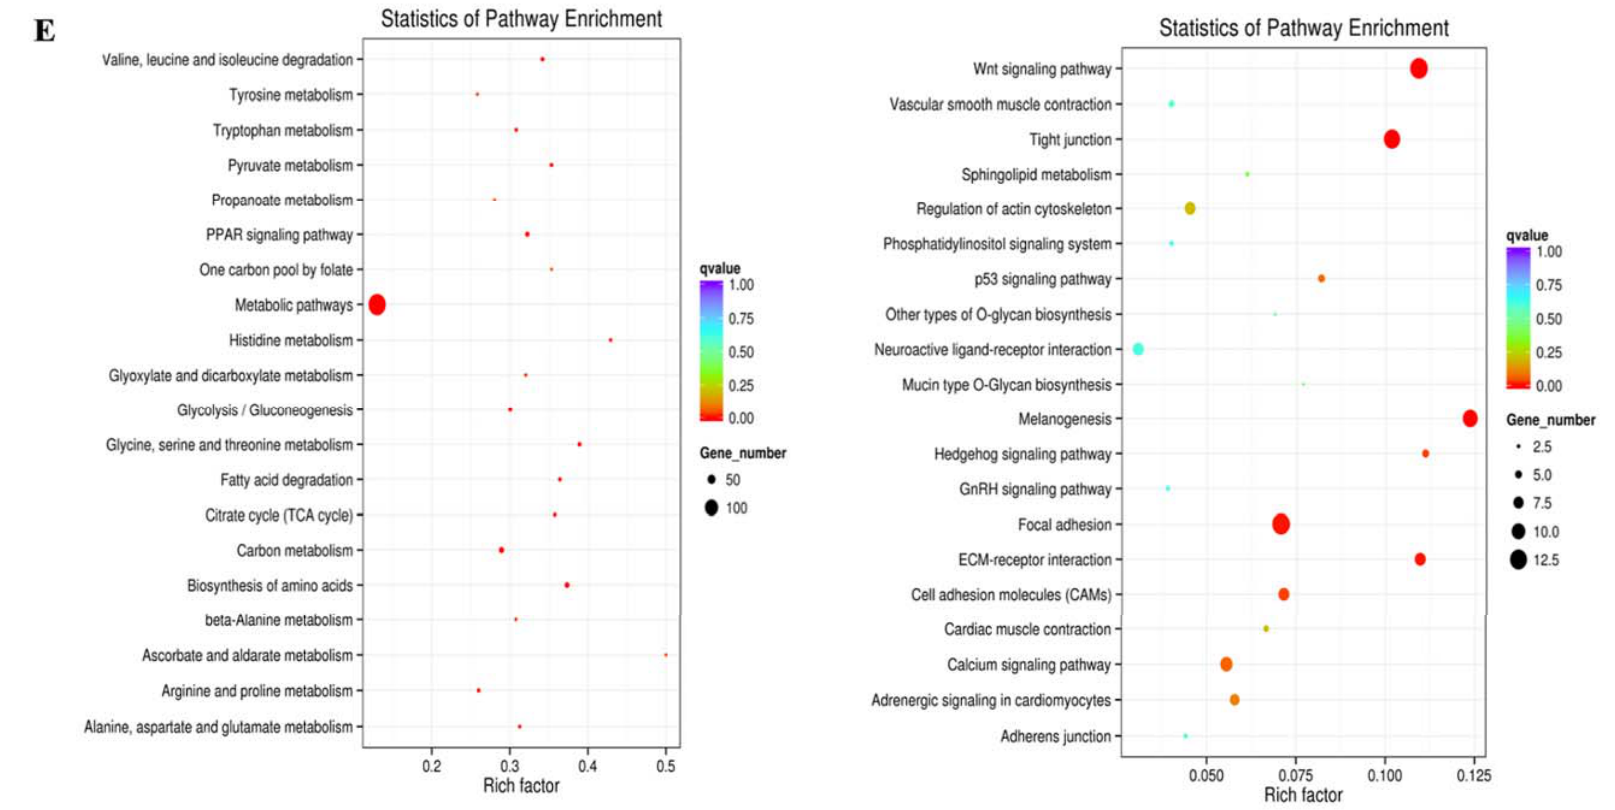
Figure 3. mRNA expression profiles in NDV-infected chicken embryonic tissues. ( A ) Venn diagram of RNA-Seq showing the number of common up- and downregulated mRNAs in F48E9 and La Sota infections. Purple and yellow represent the differentially expressed genes after infection with F48E9 and La Sota, respectively, and the common parts represent the same differentially expressed genes when infected with F48E9 and La Sota. The numbers in each section indicate the numbers of differentially expressed mRNAs. ( B ) Statistical table showing the number of common up- and downregulated mRNAs in response to NDV infection. ( C ) Validation of RT-qPCR analysis of ISG12(1), Mov10, Mx, OASL, TGM2, and RUNX2 in different infected and non-infected tissues. ( D ) GO analysis of the common up- and downregulated mRNAs in NDV infection. The top panel shows the GO enrichment analysis of each of the top 20 significant differences in the upregulated mRNAs, and the bottom panel shows the GO enrichment analysis of each of the top 20 significant differences in the downregulated mRNAs. ( E ) KEGG analysis of the common up- and downregulated mRNAs in NDV infection. The left panel shows the KEGG enrichment analysis of each of the top 20 significant differences in the upregulated mRNAs, and the right panel shows the KEGG enrichment analysis of each of the top 20 significant differences in the downregulated mRNAs.